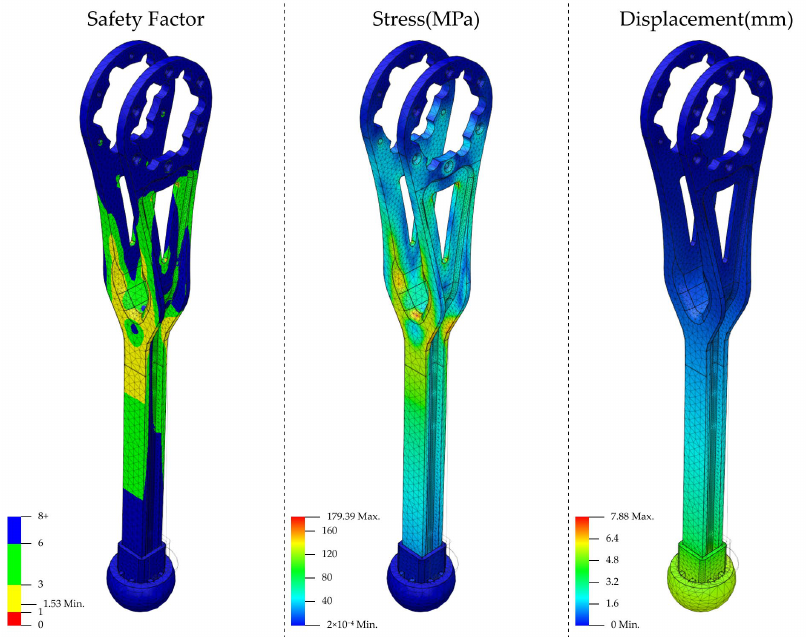
Figure 17. Analysis of condition 1 for the lower link. From left to right are safety factor, stress, and displacement.